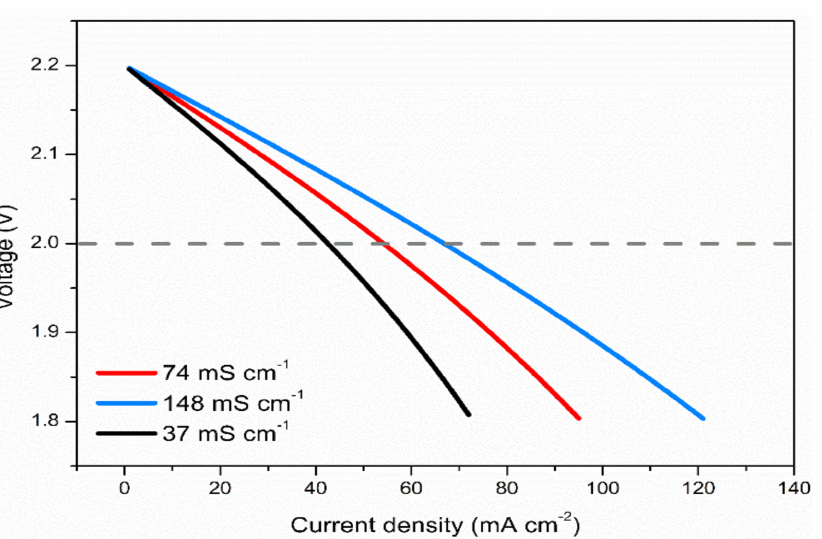
Figure 8. Effect of different bulk electrolyte conductivities. SOC: 50%; flow rate: 25 mL min − 1 ; temperature: 300